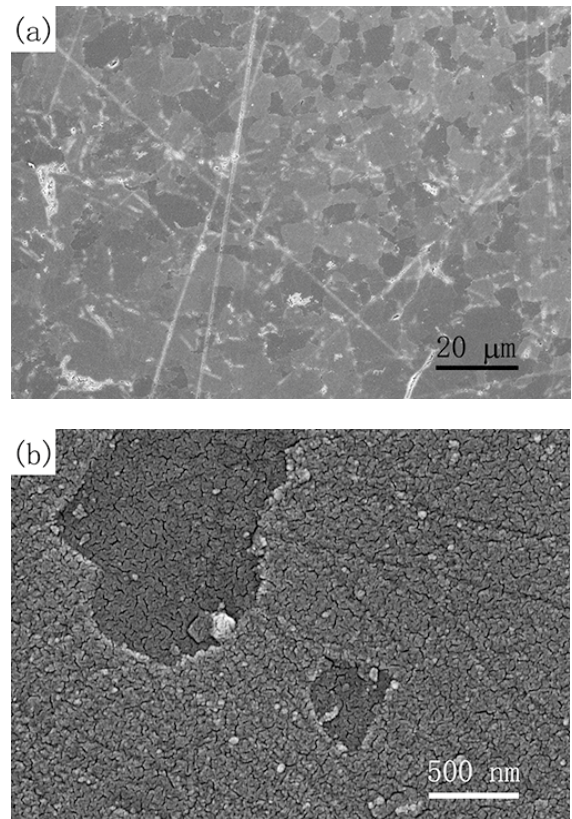
Figure 2. Low-angle backscattered electron images showing the orientation contrast, grain sizes, and shapes of recrystallized olivine grains. ( a ) All grains are irregular with wavy grain boundaries. Microfractures and microcracking exist in the deformed olivine. ( b ) Very small particles (about 500 nm; the gray particle in the lower middle) existed in the sample.